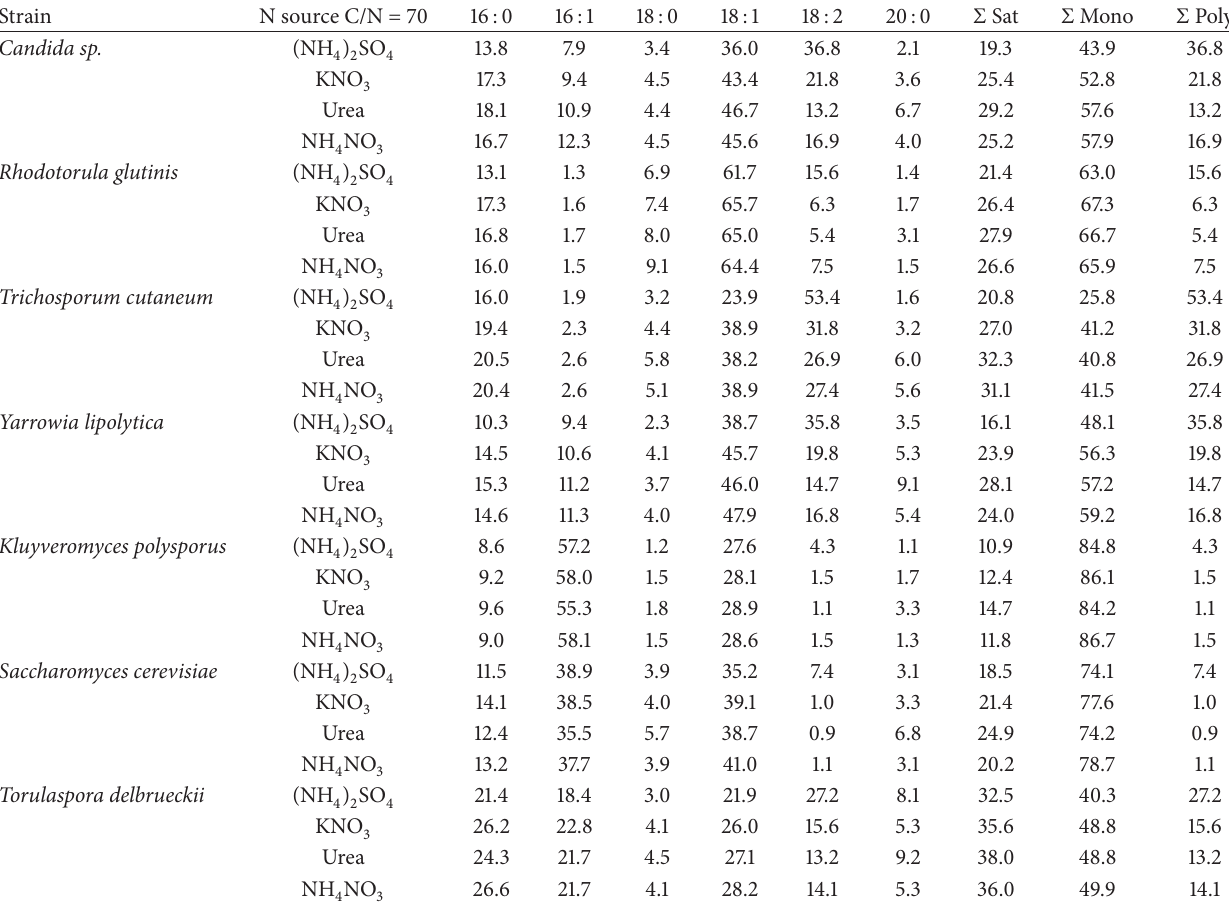
Table 1: Proportion (%) of fatty acids and total mono- and polyunsaturated fatty acids in the 7 yeast strains cultivated with 4 nitrogen sources. Strain Candida sp.